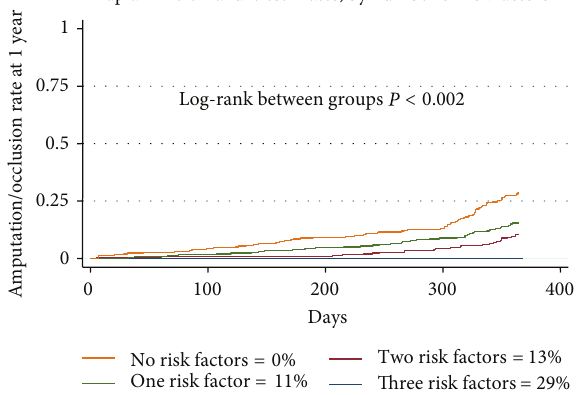
F 4: Validation of the risk prediction model using data from the VSGNE from